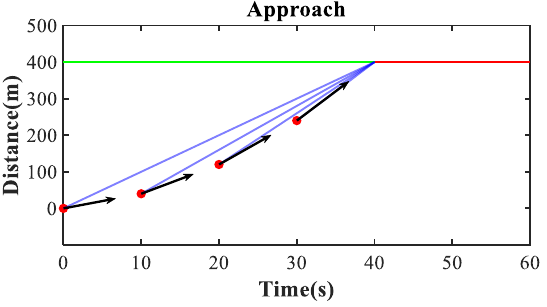
Figure 4. Illustration of discretization constraints.